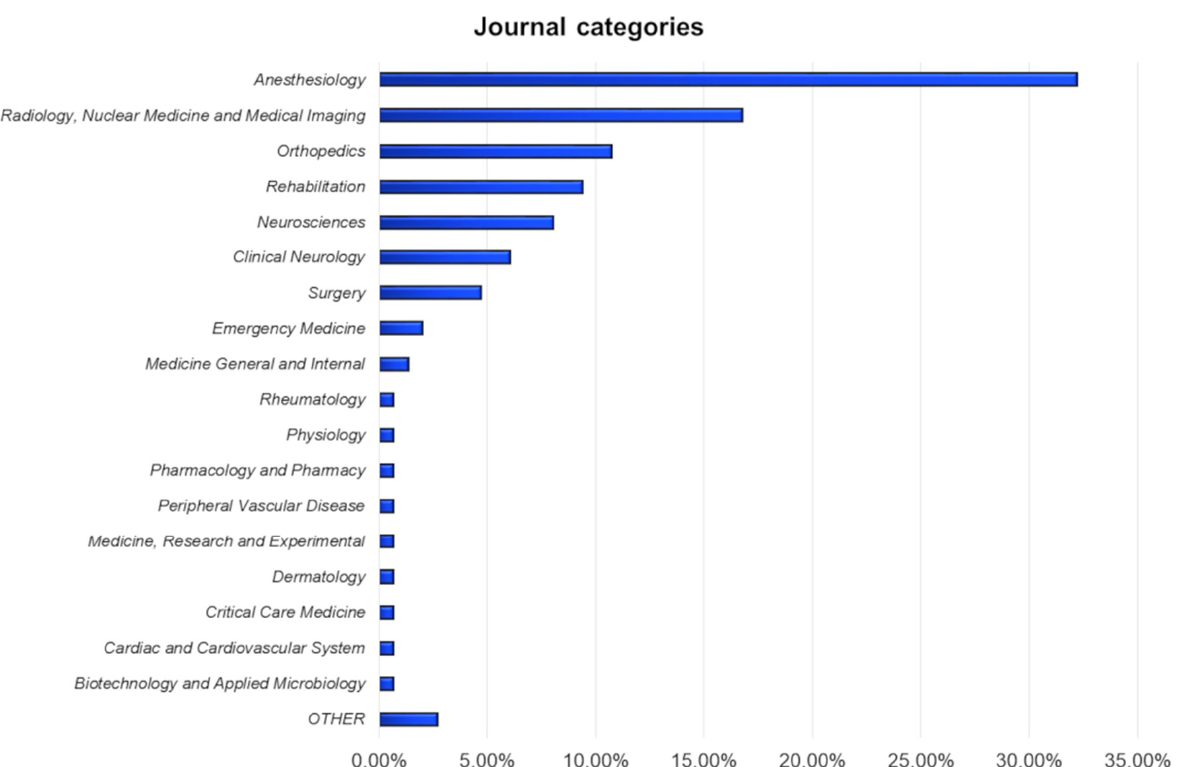
Figure 3. Journal categories of the papers. The results are expressed as percentage with respect to the total amount of papers.